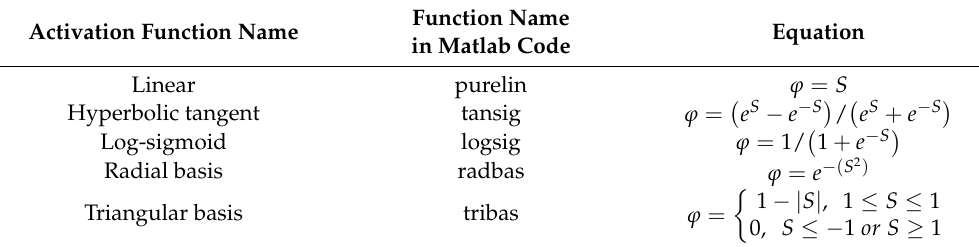
Table 1. List of some different more common activation functions, where S represents n j